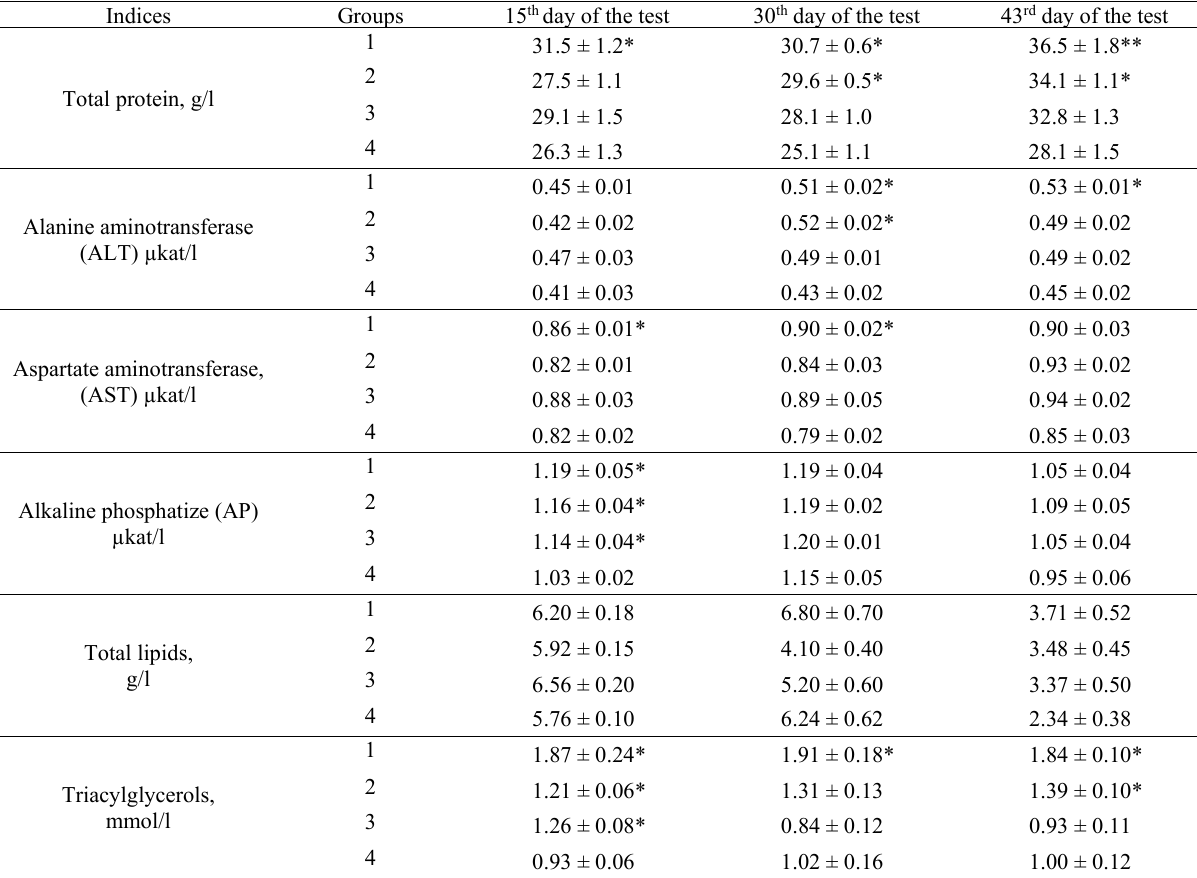
Biochemical parameters of broiler chicken’s blood serum at the application of probiotic feed additives (M ± m, n = 10) Indices